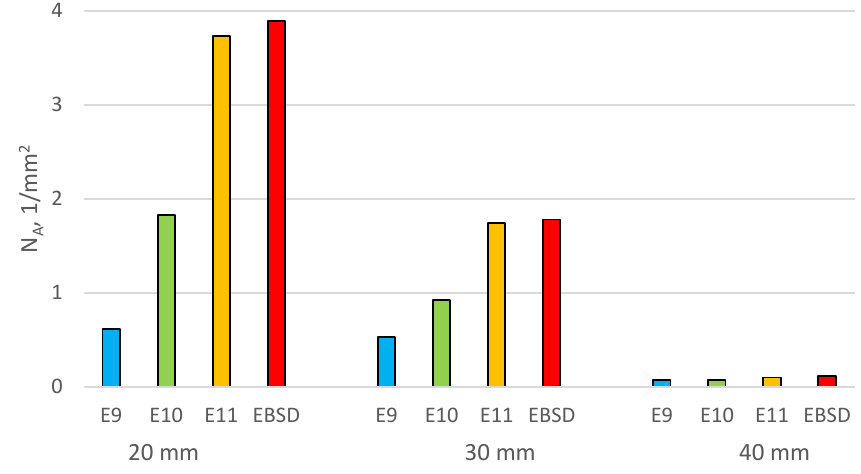
Figure 10. Number of grains of primary austenite N A in the tested samples. On the basis of the results, pictures of EBSD microstructures and simulation imaging were matched. The results are shown in Figure 11.